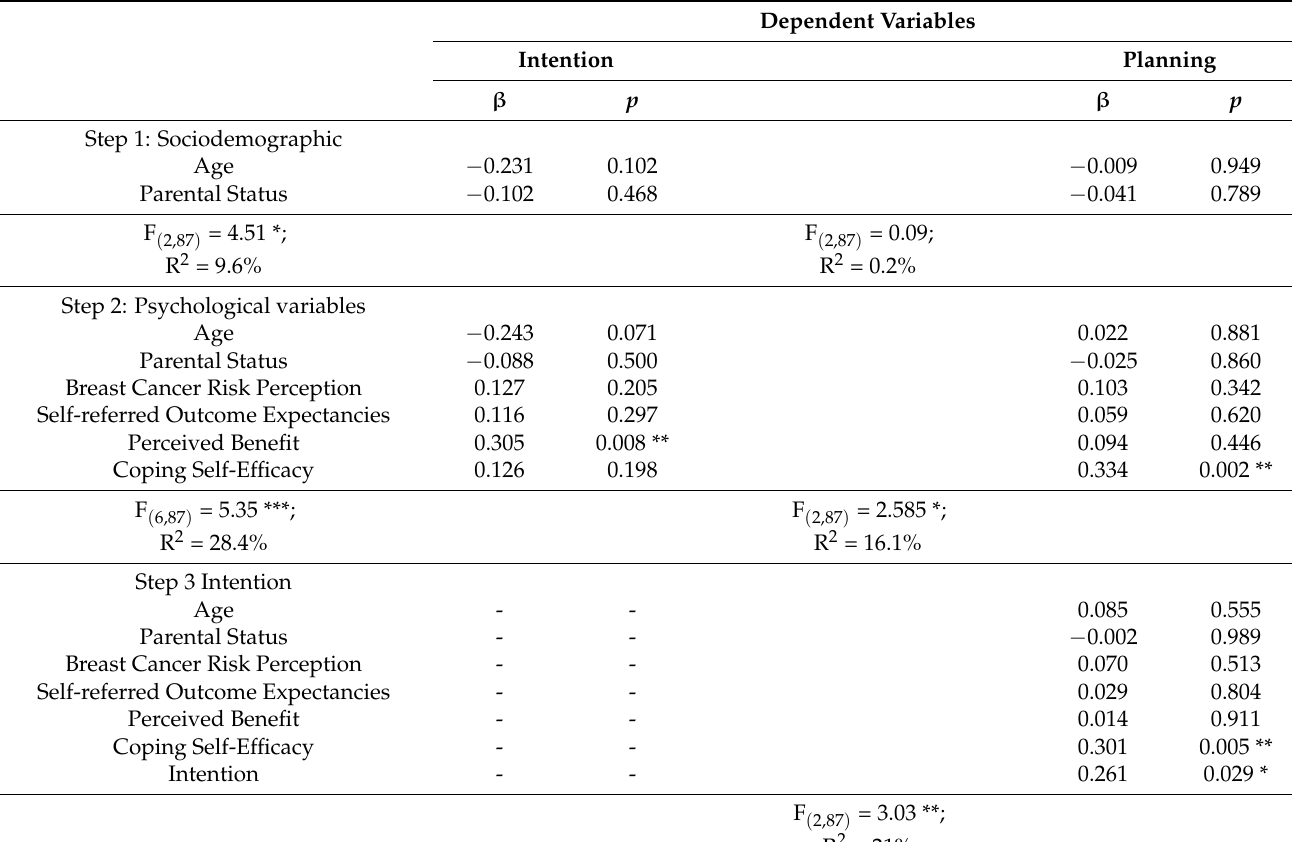
Table 2. Regression tables.